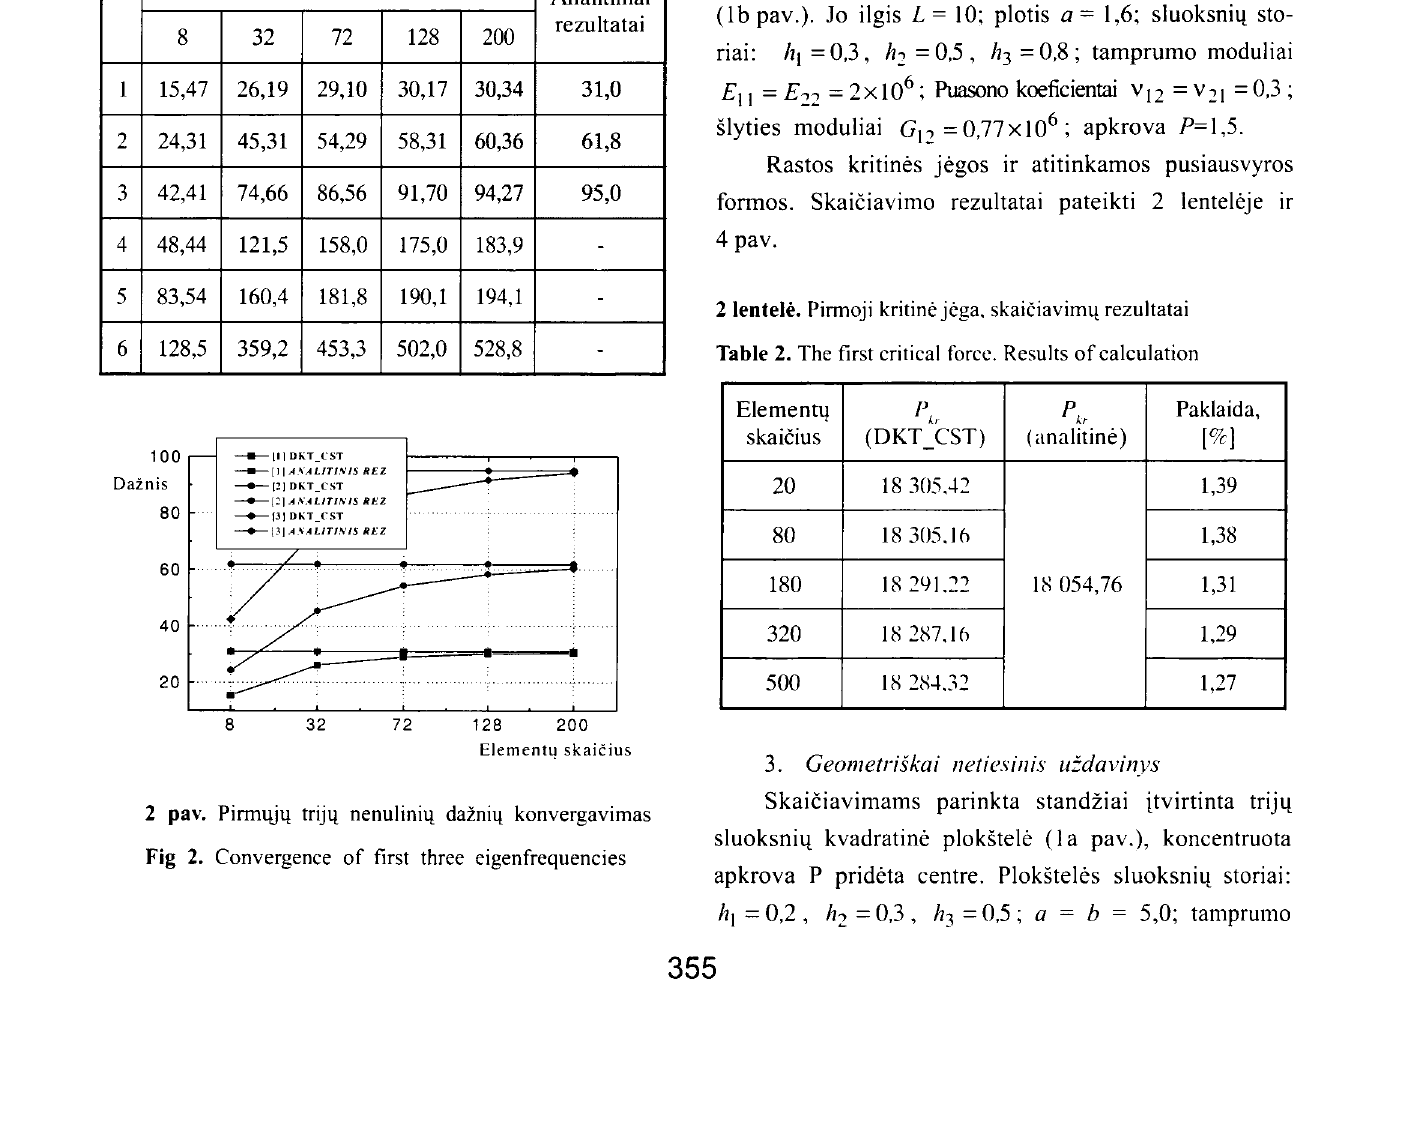
Fig 3. The first six eigenvectors 2. Pradinio pastovumo uzdavinys Skaiciavimams parinktas trijq sluoksniq strypas (lb pav.). Jo ilgis L = 10; plotis a= 1,6; sluoksni4 sto